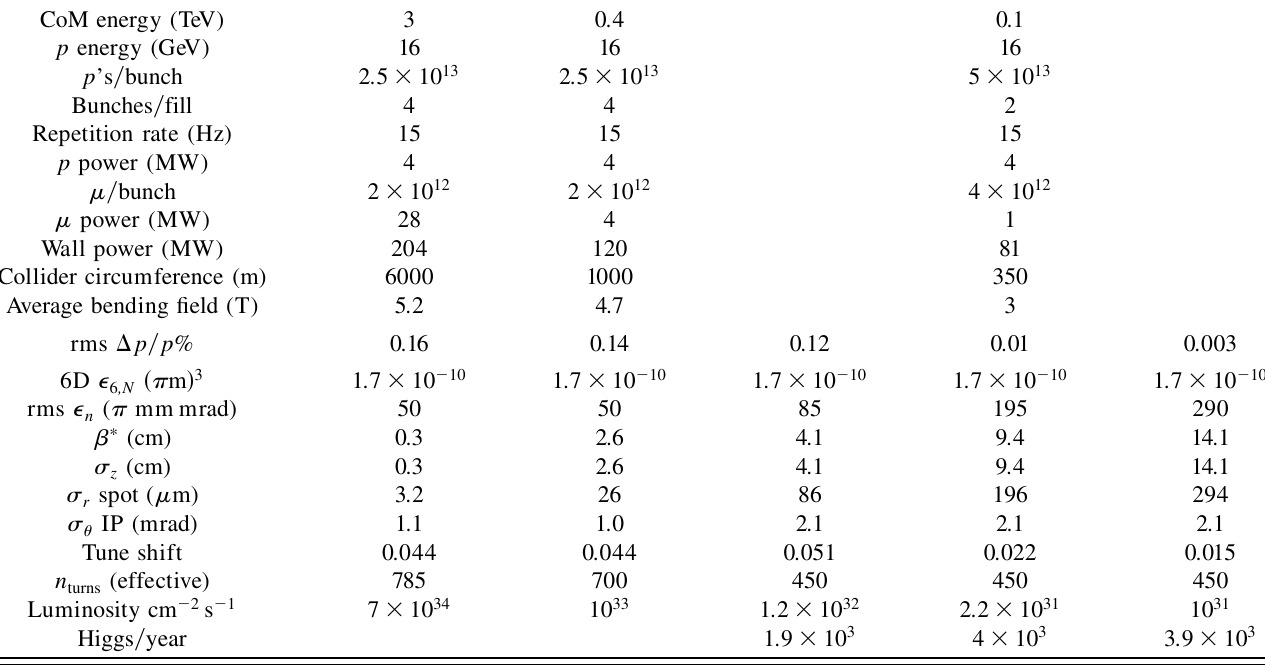
TABLE XIV. Baseline parameters for high- and low-energy muon colliders. Higgs = year assumes a cross section (cid:31) (cid:4) 5 (cid:5) 10 4 fb ; a Higgs width 5 (cid:4) 2 : 7 MeV ; 1 yr (cid:4) 10 7 s